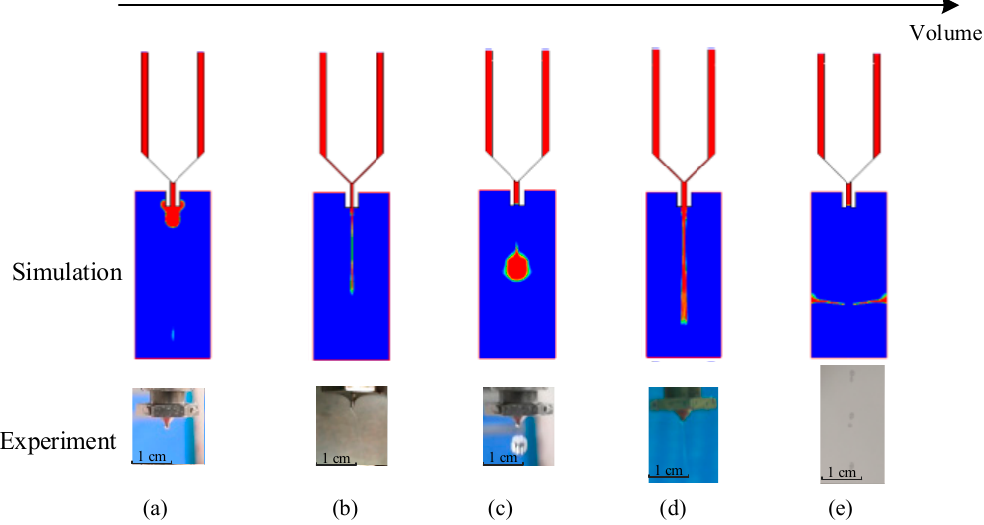
Figure 5. Droplet morphologies with different volumes: ( a ) Adhesion; ( b ) residual liquid; ( c ) normal droplet; ( d ) flow-stream; ( e ) scattered dots.